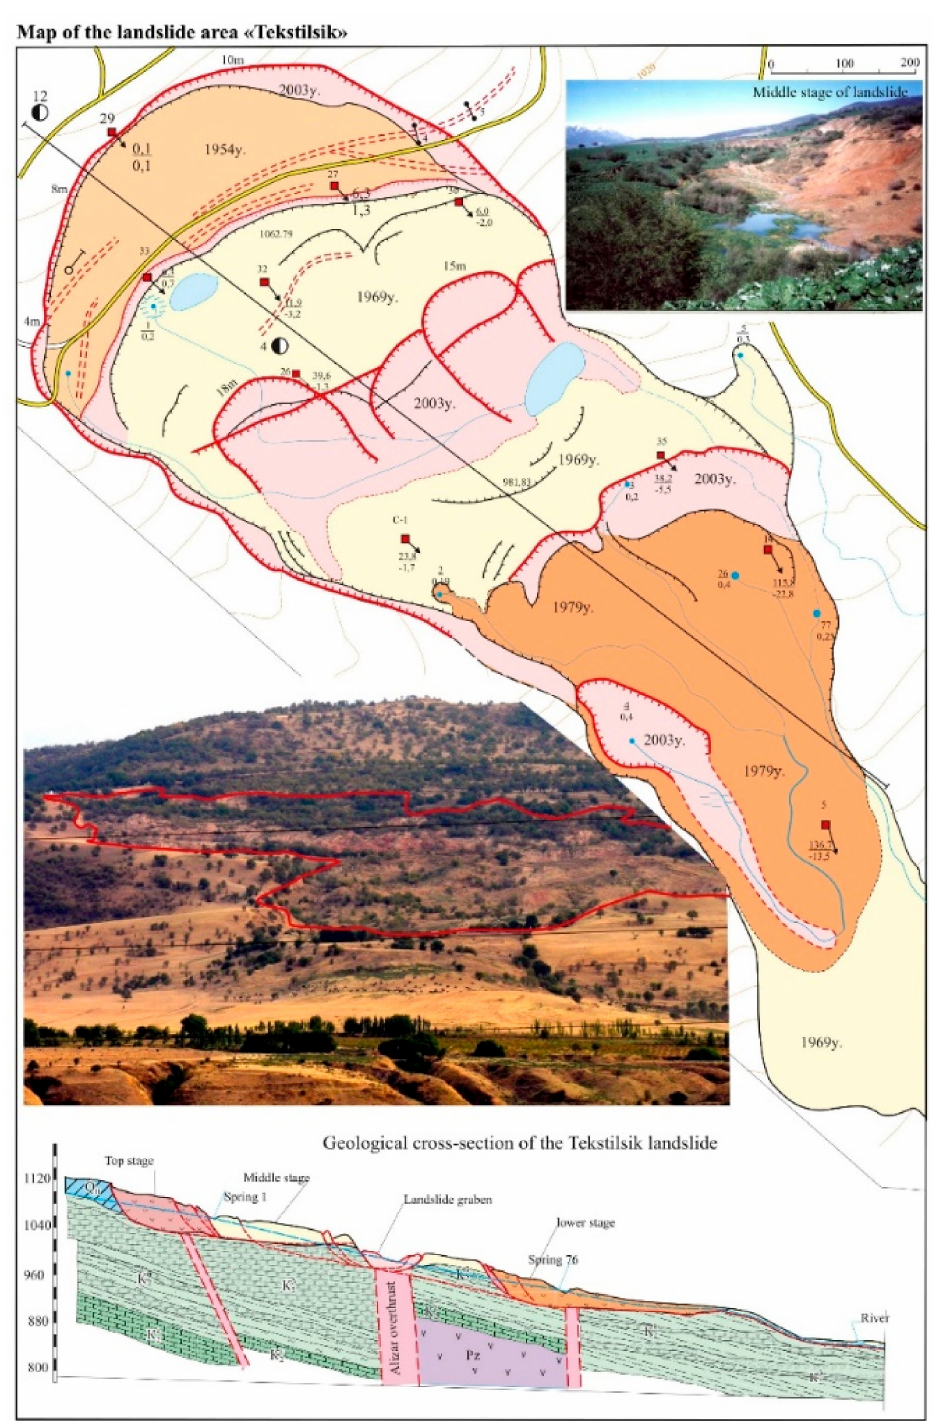
Figure 1. Map and cross-section of the Tekstilsik